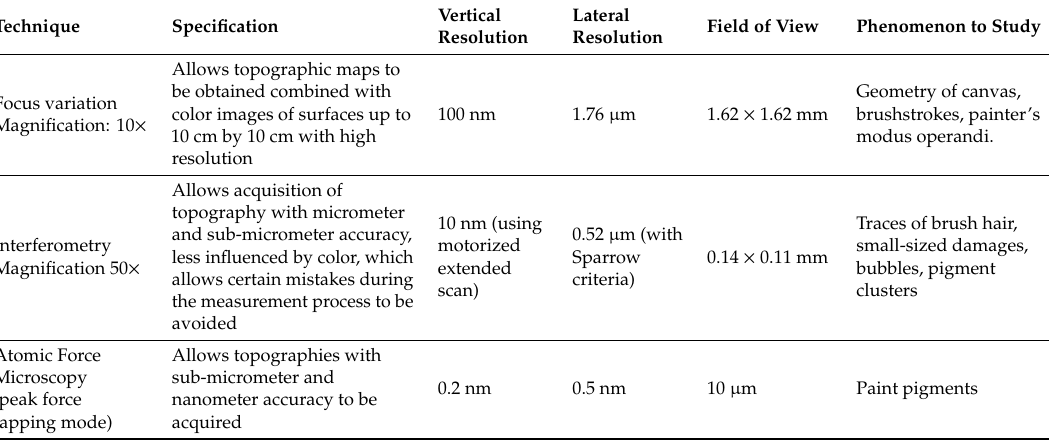
Table 1. Summary table of surface topography investigation techniques.